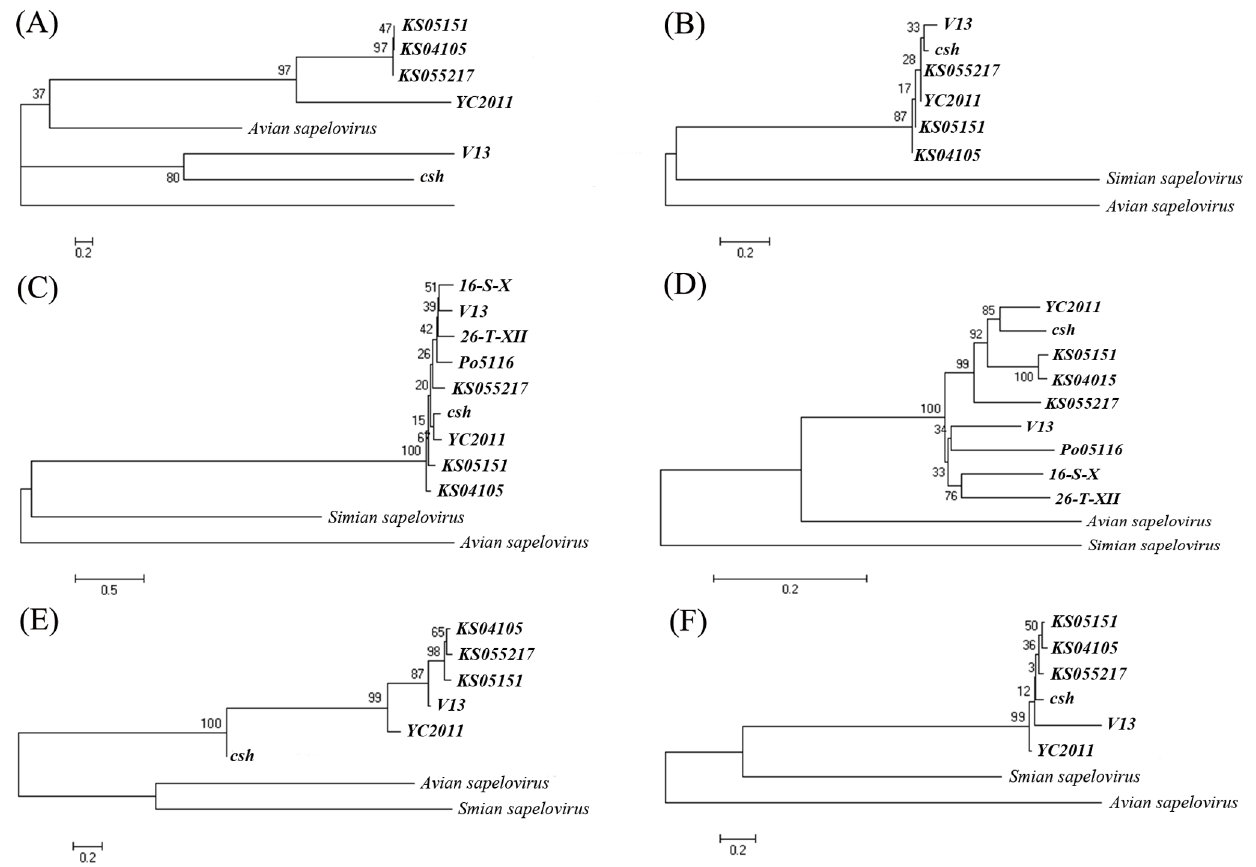
Figure 3. Sequence comparisons and phylogenetic analysis of Korea porcine sapelovirus strains. The phylogenetic tree of 5 9 untranslated region (UTR) sequence (A), 3 9 UTR sequence (B), P1 nucleotide sequence (C), VP1 nucleotide sequence (D), P2 nucleotide sequence (E), and P3 nucleotide sequence (F) were constructed using the neighbor-joining method with 1,000 bootstrap replicates, and the branch length is indicated at each branch node.